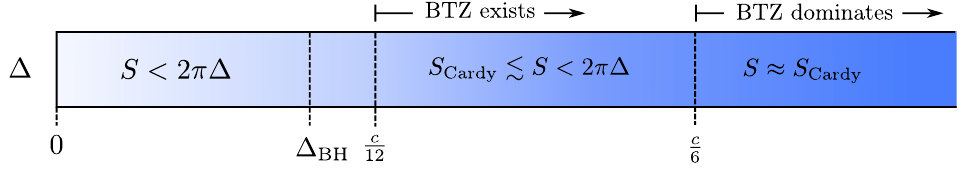
Figure 1 . Universal features of the spectrum of 3D